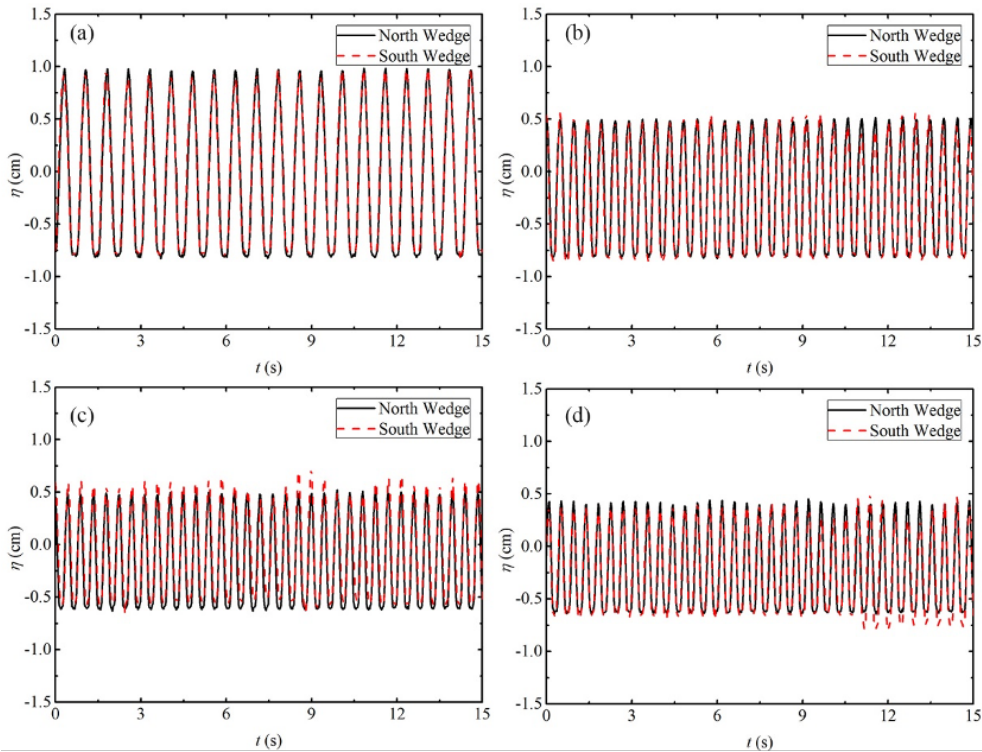
Figure A3. Tests of monochromatic wave generation by each wavemaker with the corresponding measurements by the closest probes. In each panel, the solid black line (red dashed line) represents the measurement by probe 1 (probe 2) of a wave generated by a monochromatic oscillation of the north wedge (south wedge). ( a ) Monochromatic frequency f = 1.33 Hz. ( b ) Monochromatic frequency f = 2.08 Hz. ( c ) Monochromatic frequency f = 2.22 Hz. ( d ) Monochromatic frequency f = 2.30